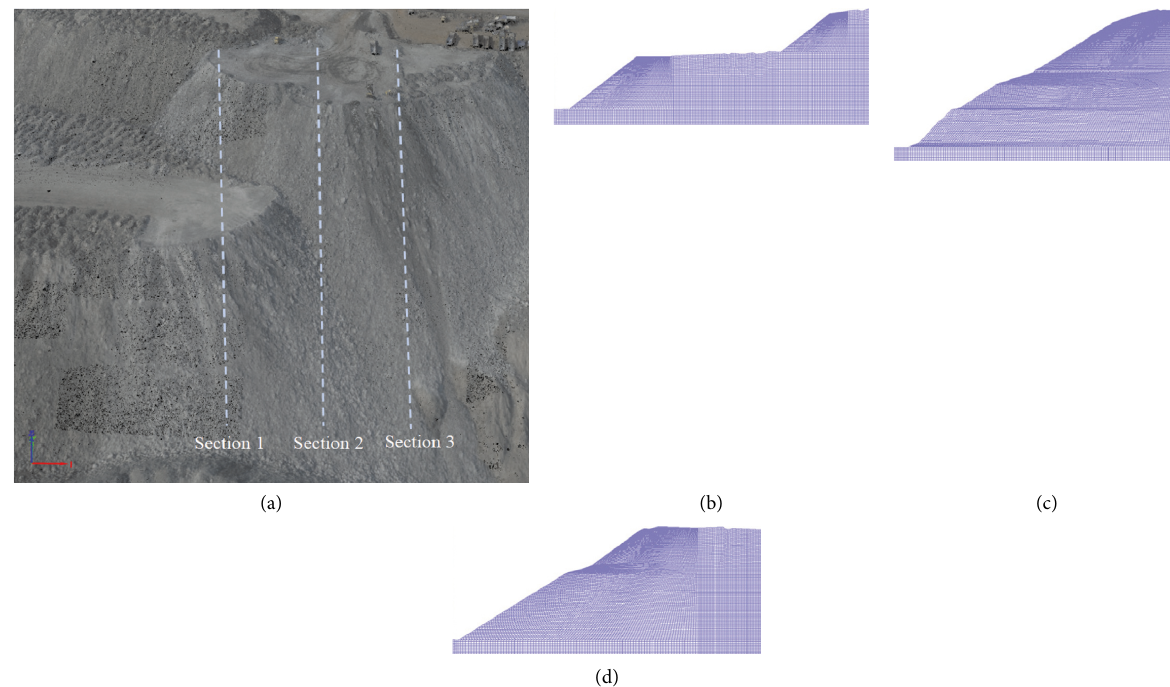
Figure 9: (a) Three sections marked with dotted lines on the active dumping slope. (b–d) Geometry of section 1, section 2, and section 3, respectively. Table 2: FOS of 3 sections in static numerical simulation condition with deformation. Section